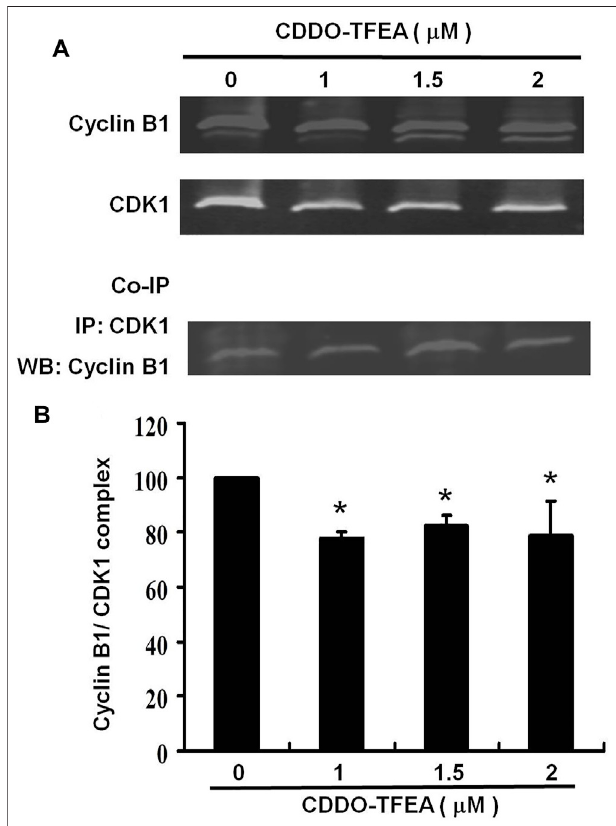
FIGURE8| Co-Immunoprecipitationisaneffective meansofquantifying protein – protein interactions in cells. The primary and secondary targets were CDK1 and cyclin B1, respectively. Cells were treated with CDDO-TFEA for 24 h. Gene and protein expression was detected through Western blotting. (B) Results are expressed as a percentage of the control, with the control being 100%.